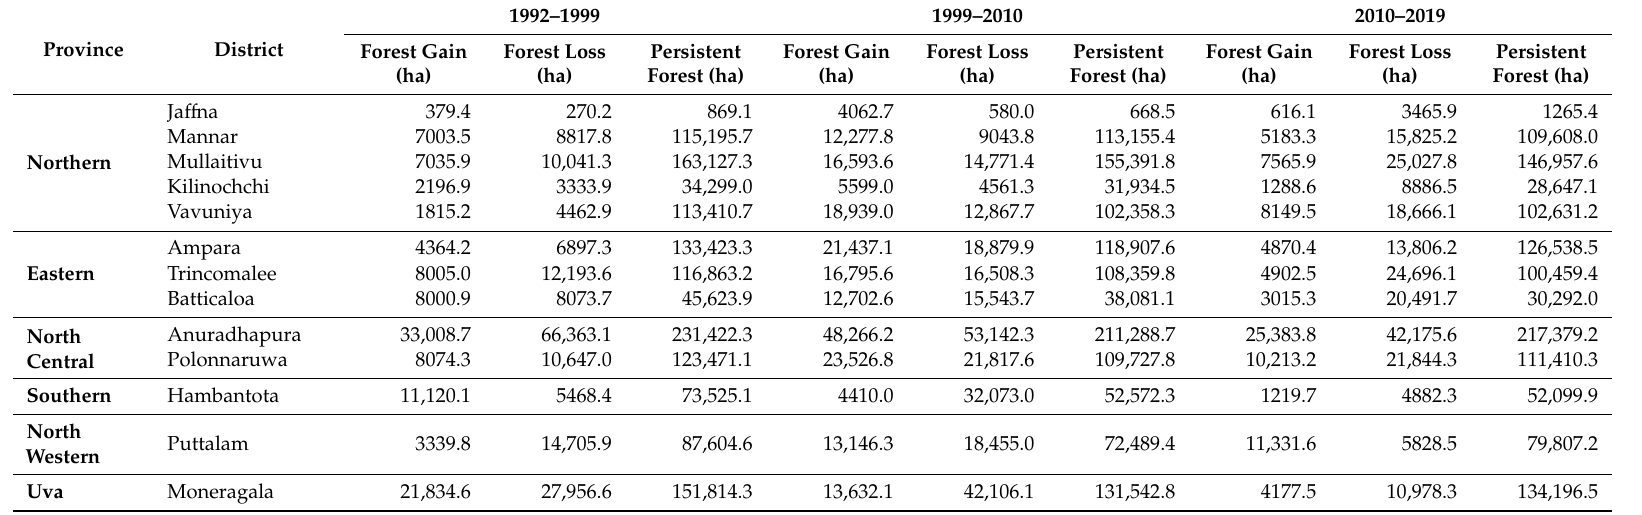
Table A3. Forest gain, loss, and persistence in the DZ in 13 administrative districts of Sri